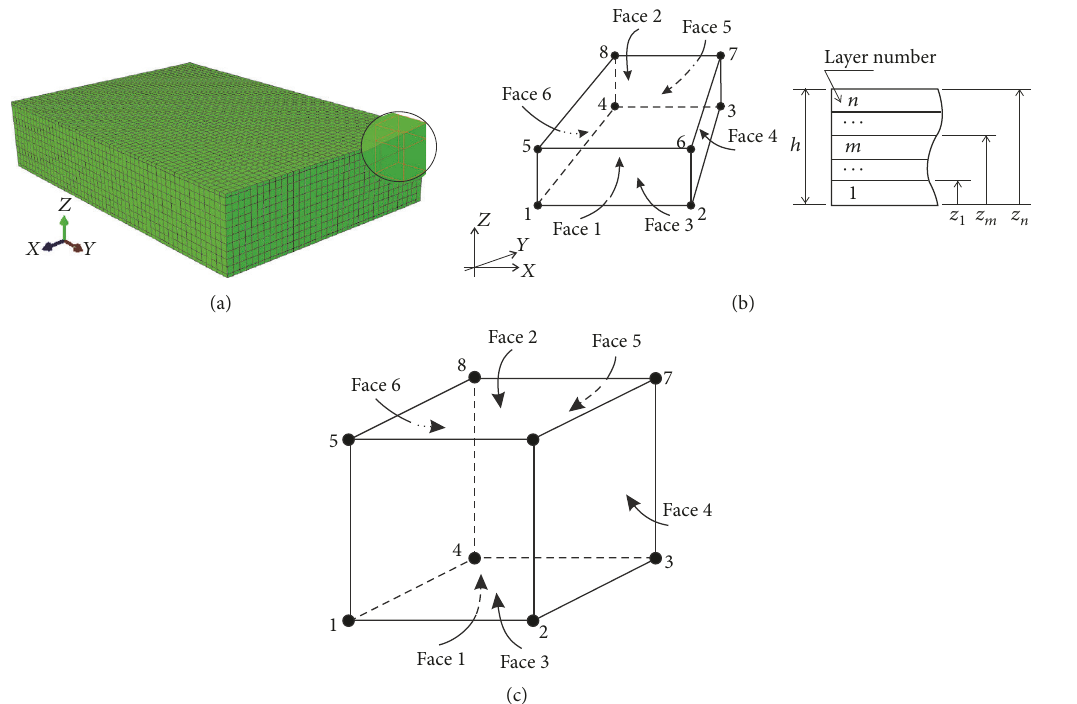
Figure 2: Aspects of finite element discretization: (a) a 3D model of sandwich plate; (b) continuous shell finite element; and (c) solid-brick finite